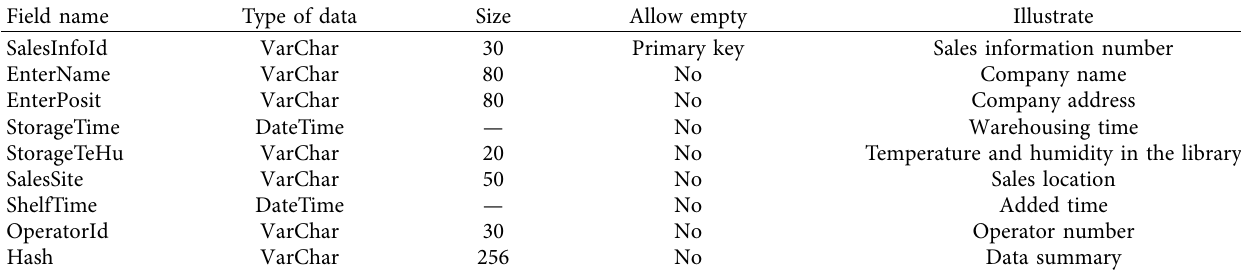
Table 6: Sales information